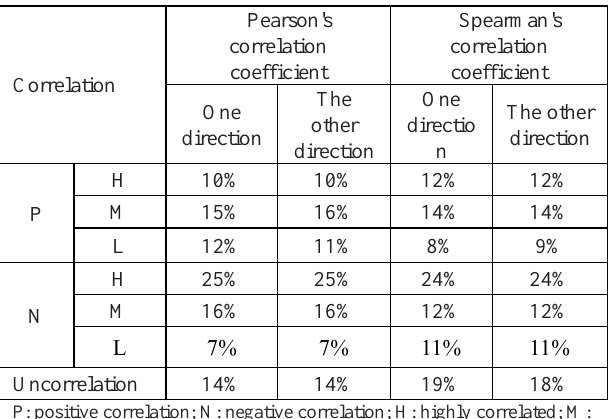
Table 4. Correlation analysis